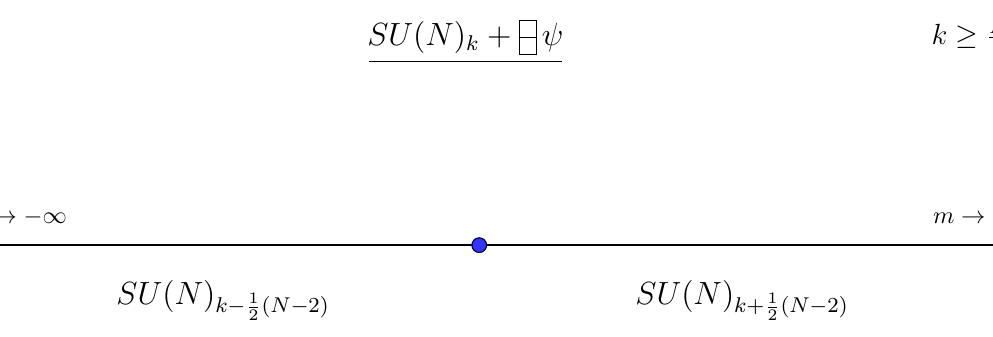
. The solid circle 2